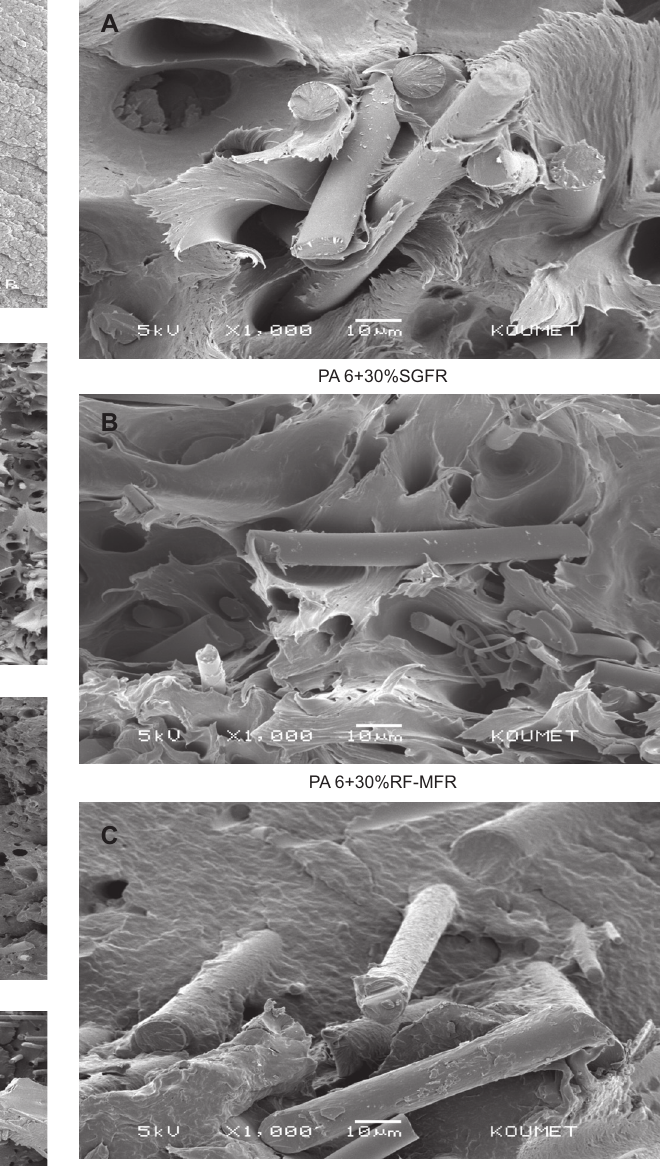
Figure 9 Scanning electron micrograph of tensile fracture cross section for PA6 with (A) 30 wt% short glass fiber-reinforced PA6 composite, (B) 30 wt% RF-mineral fiber-reinforced PA6 composite, and (C) 20 wt% short glass fiber+10 wt% RF-mineral fiber-reinforced PA6 hybrid